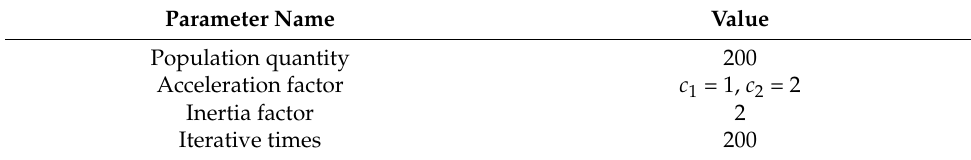
Table 7. Parameters of PSO